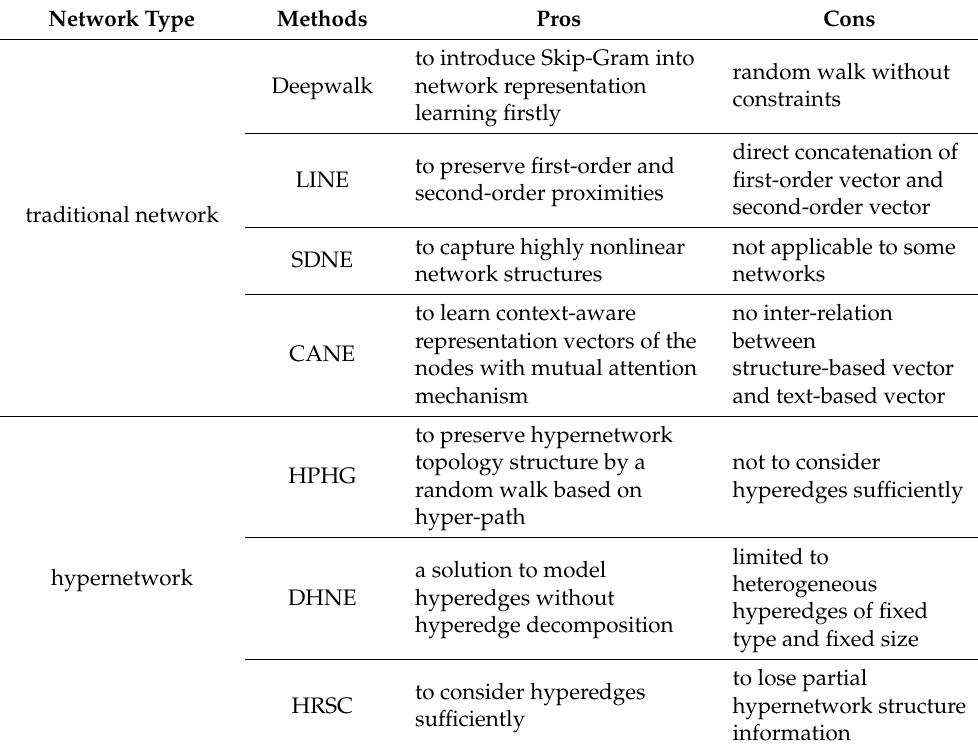
Table 1. The statistics of the pros and